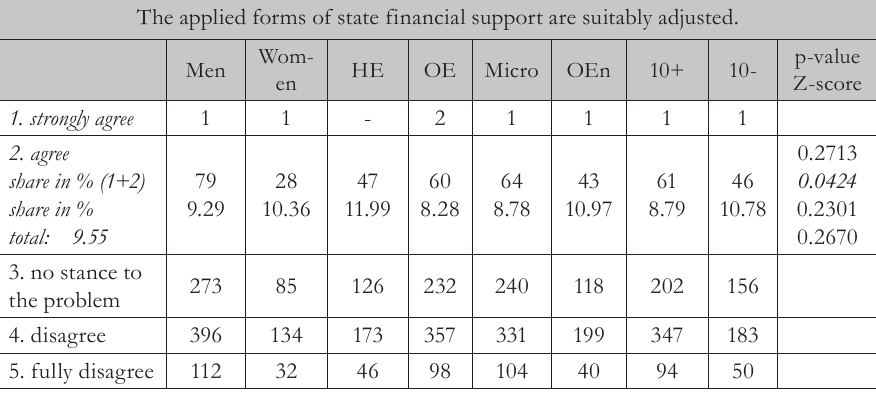
Tab. 1 - The evaluation of the state financial support in the Czech Republic. Source: own source The applied forms of state financial support are suitably